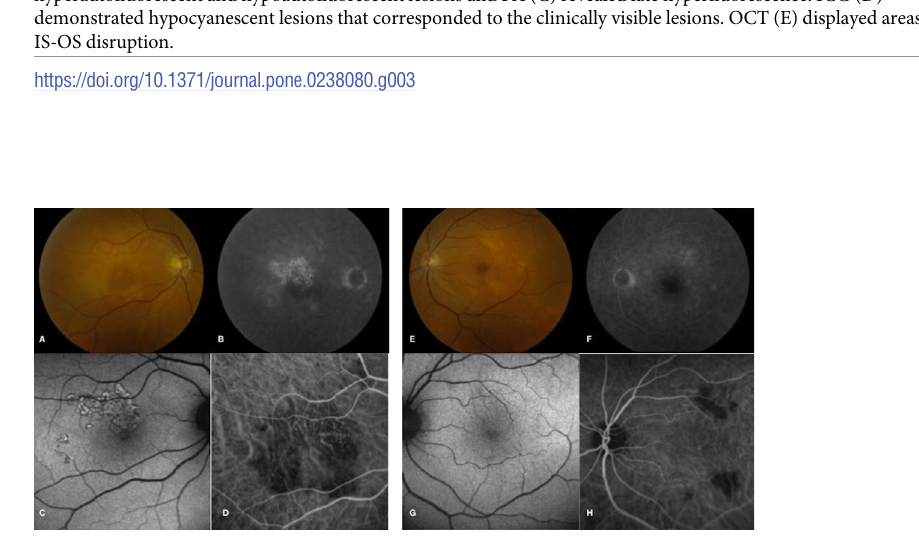
Fig 4. Multimodal imaging demonstrates lesions are more apparent on ICG-A than other imaging modalities in patient 3. Initial fundus photograph of the right eye (A) shows multifocal cream-colored lesions with leakage on FA (B). FAF (C) shows hyperautofluorescence only partially corresponding to the area of choroidal disease, while ICG-A (D) outlines hypocyanescent lesions that appear larger than visualized on fundus photography or FAF. In the left eye, a fundus photograph (E) shows choroidal lesions, minimal FA hyperfluorescence (F) and minimal changes on FAF (G). ICG-A (H) highlights the choroidal lesions that are more numerous than seen on fundus exam or FAF.